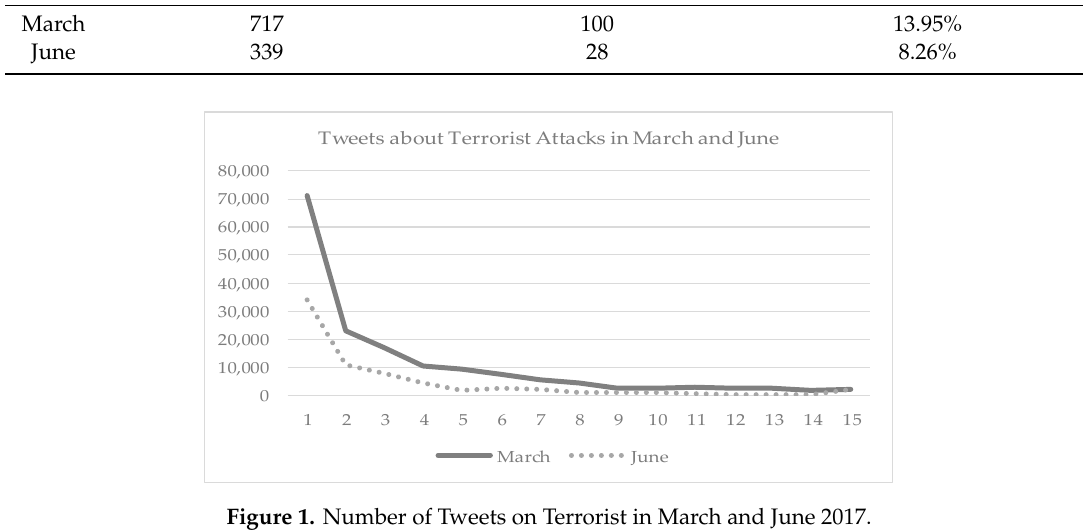
Figure 1. Number of Tweets on Terrorist in March and June 2017.